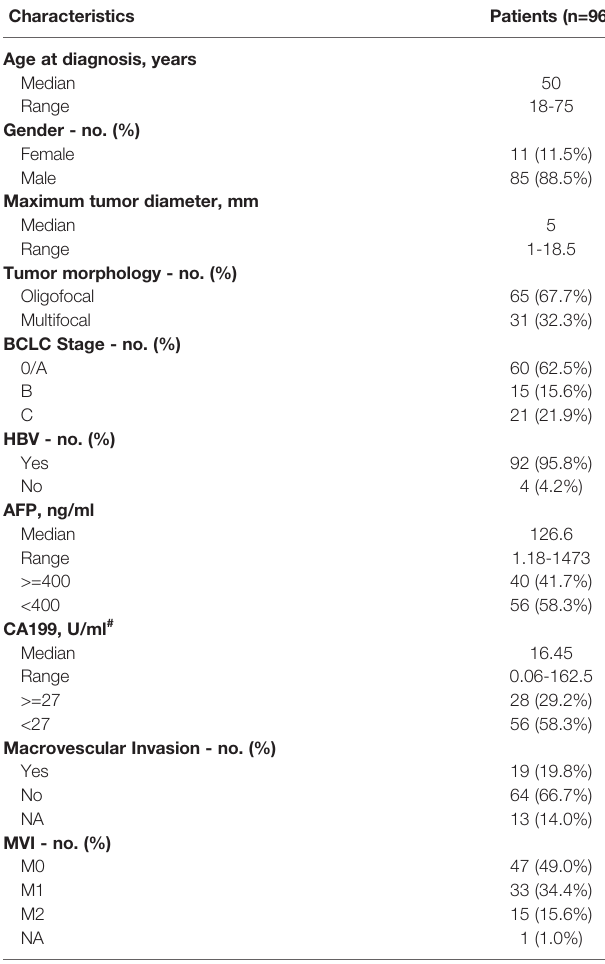
TABLE 1 | Clinical characteristics of patients with primary hepatocellular carcinoma enrolled in this study.